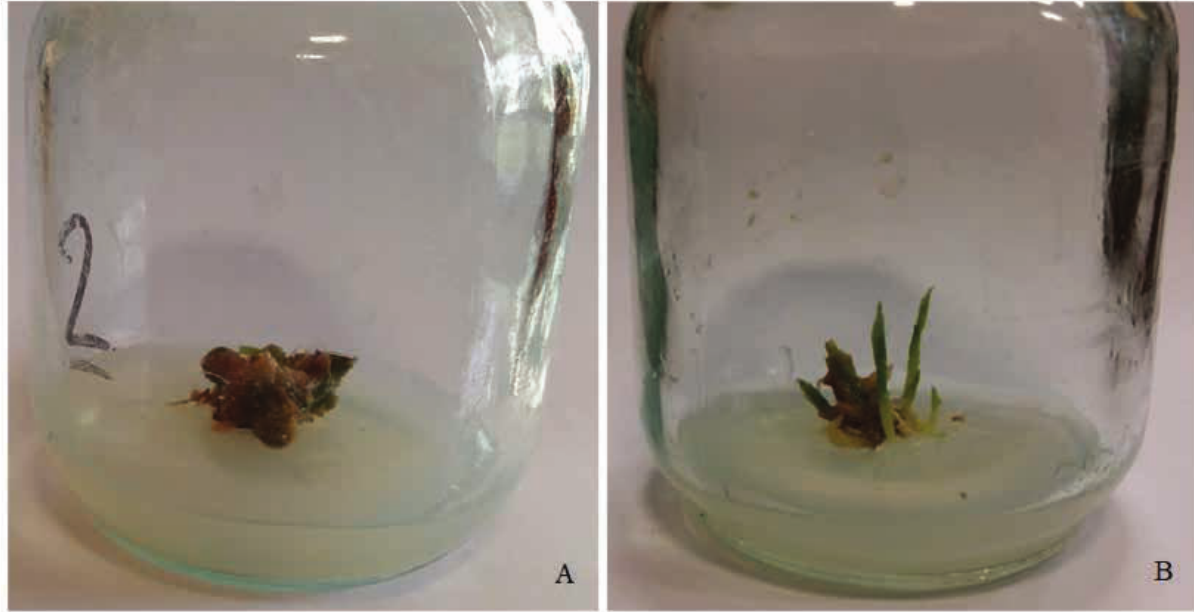
Figure 4: Callus induction on MS medium supplemented with 1 mg/l 2,4-D (A) and shoot regeneration on MS medium containing 0.5 mg/l BA (B) of ginger four weeks after cultivation.